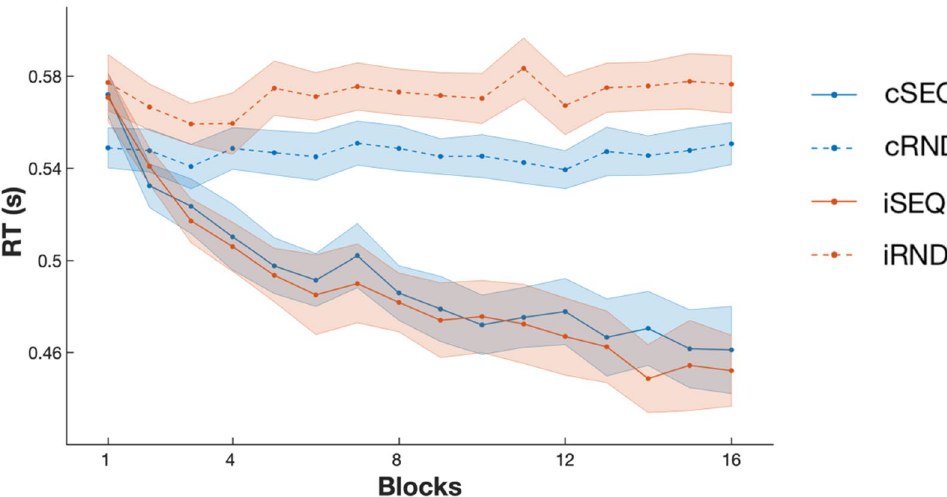
Figure 3. Behavioral results. Performance speed (reaction time, RT) improved over the course of training in the sequence task (SEQ) conditions and stayed stable in random task (RND) conditions. The stimulation intervention (c: continuous and i: intermittent) did not affect motor performance nor motor learning. Lines and dots represent average RT per block and shaded areas represent